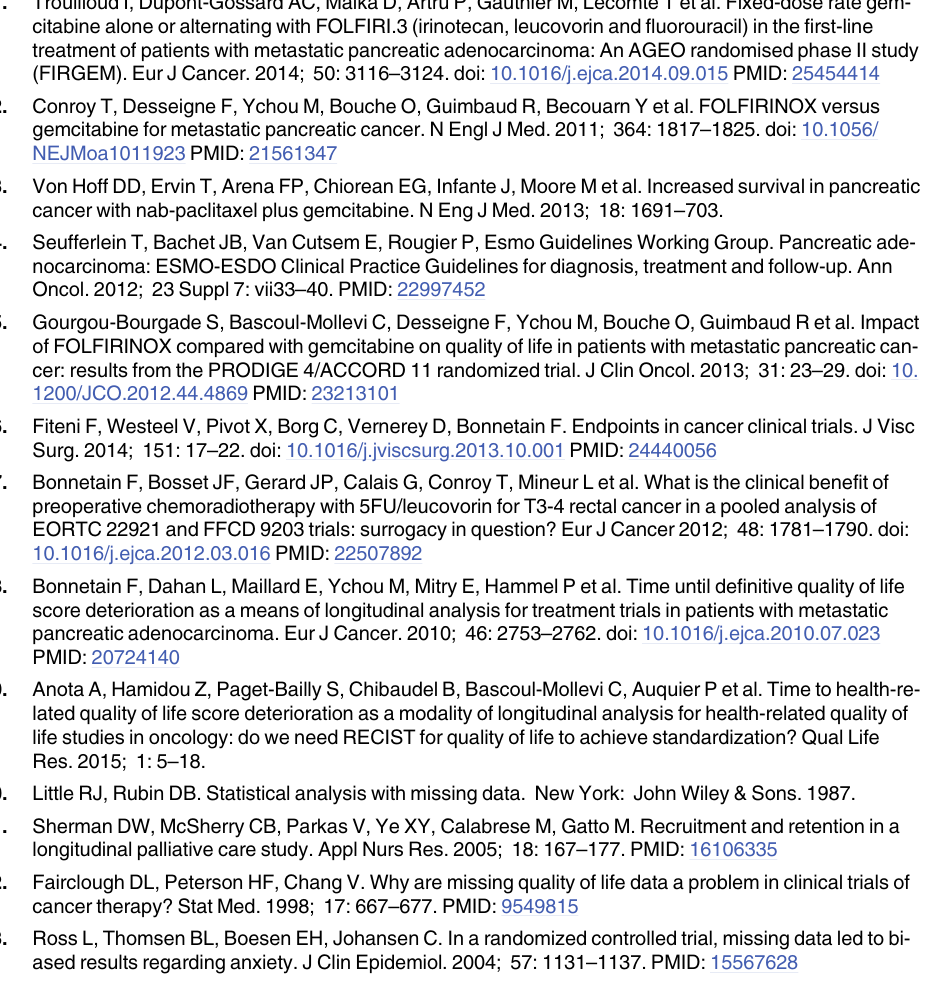
S3 Table. Results of the Kaplan-Meier estimation of the health-related quality of life deteri- oration-free survival for a QLQ-C30 score considering non-responders patients in deterio- ration since baseline and comparison between treatment arms. S4 Table. Results of the multivariate Cox regression analysis for the QFS analysis of each targeted score of the QLQ-C30 considering non-responders patients in deterioration since